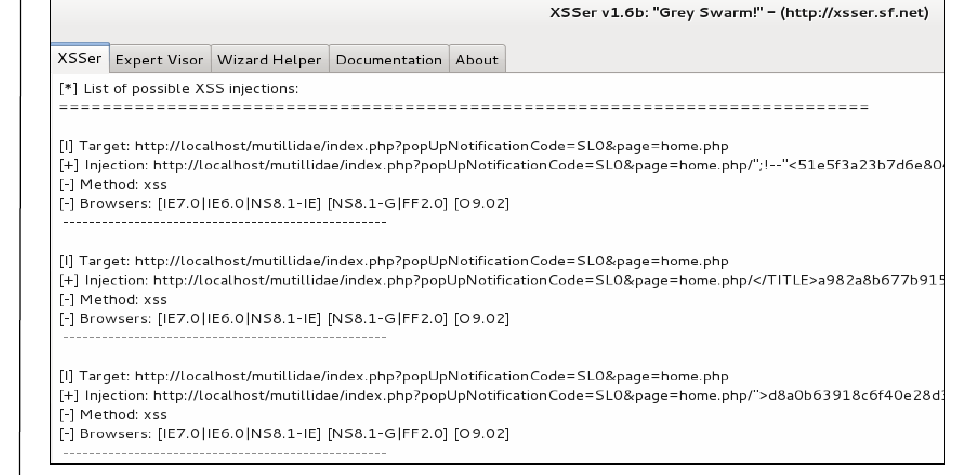
Figure 7 – XSSer – overview of a possible injection Рис . 7 – XSSer – отчет о возможных XSS инъекциях Slika – XSSer – prikaz mogu ć ih XSS